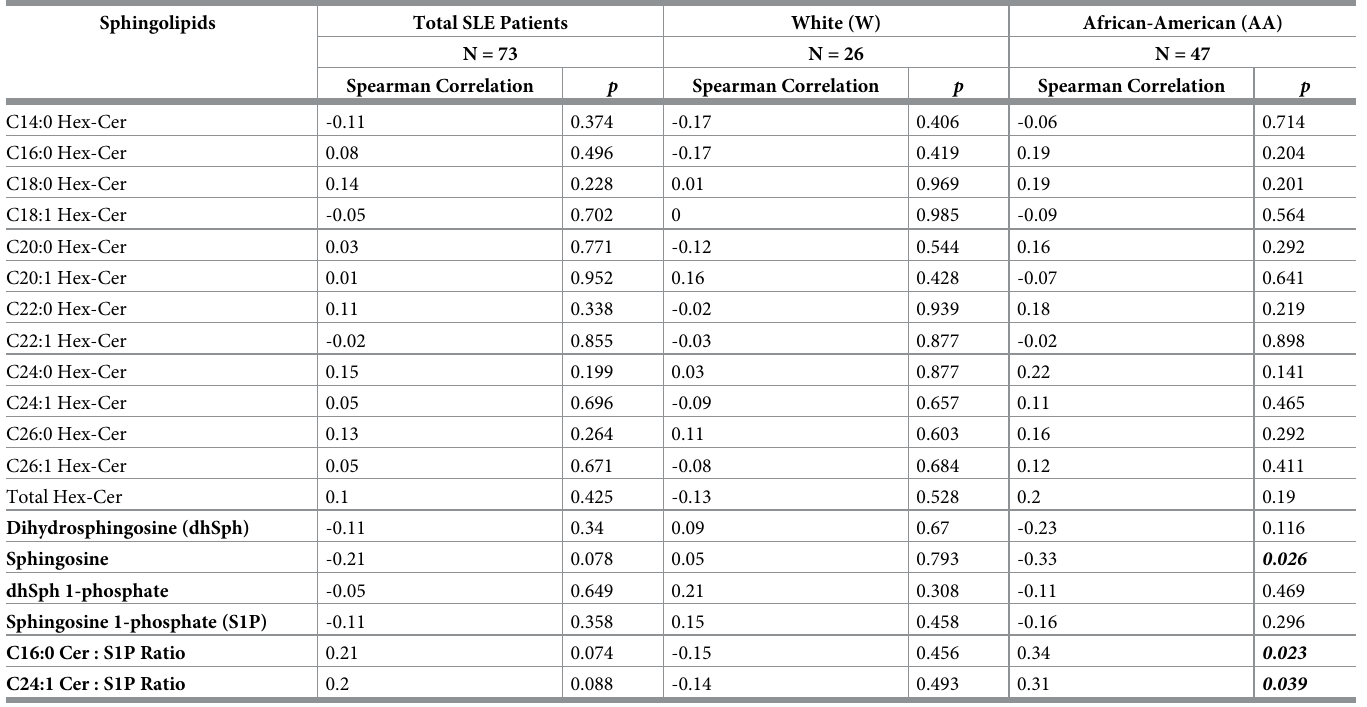
and C24:1 Cer/S1P, compared to White healthy subjects. African-American SLE patients on